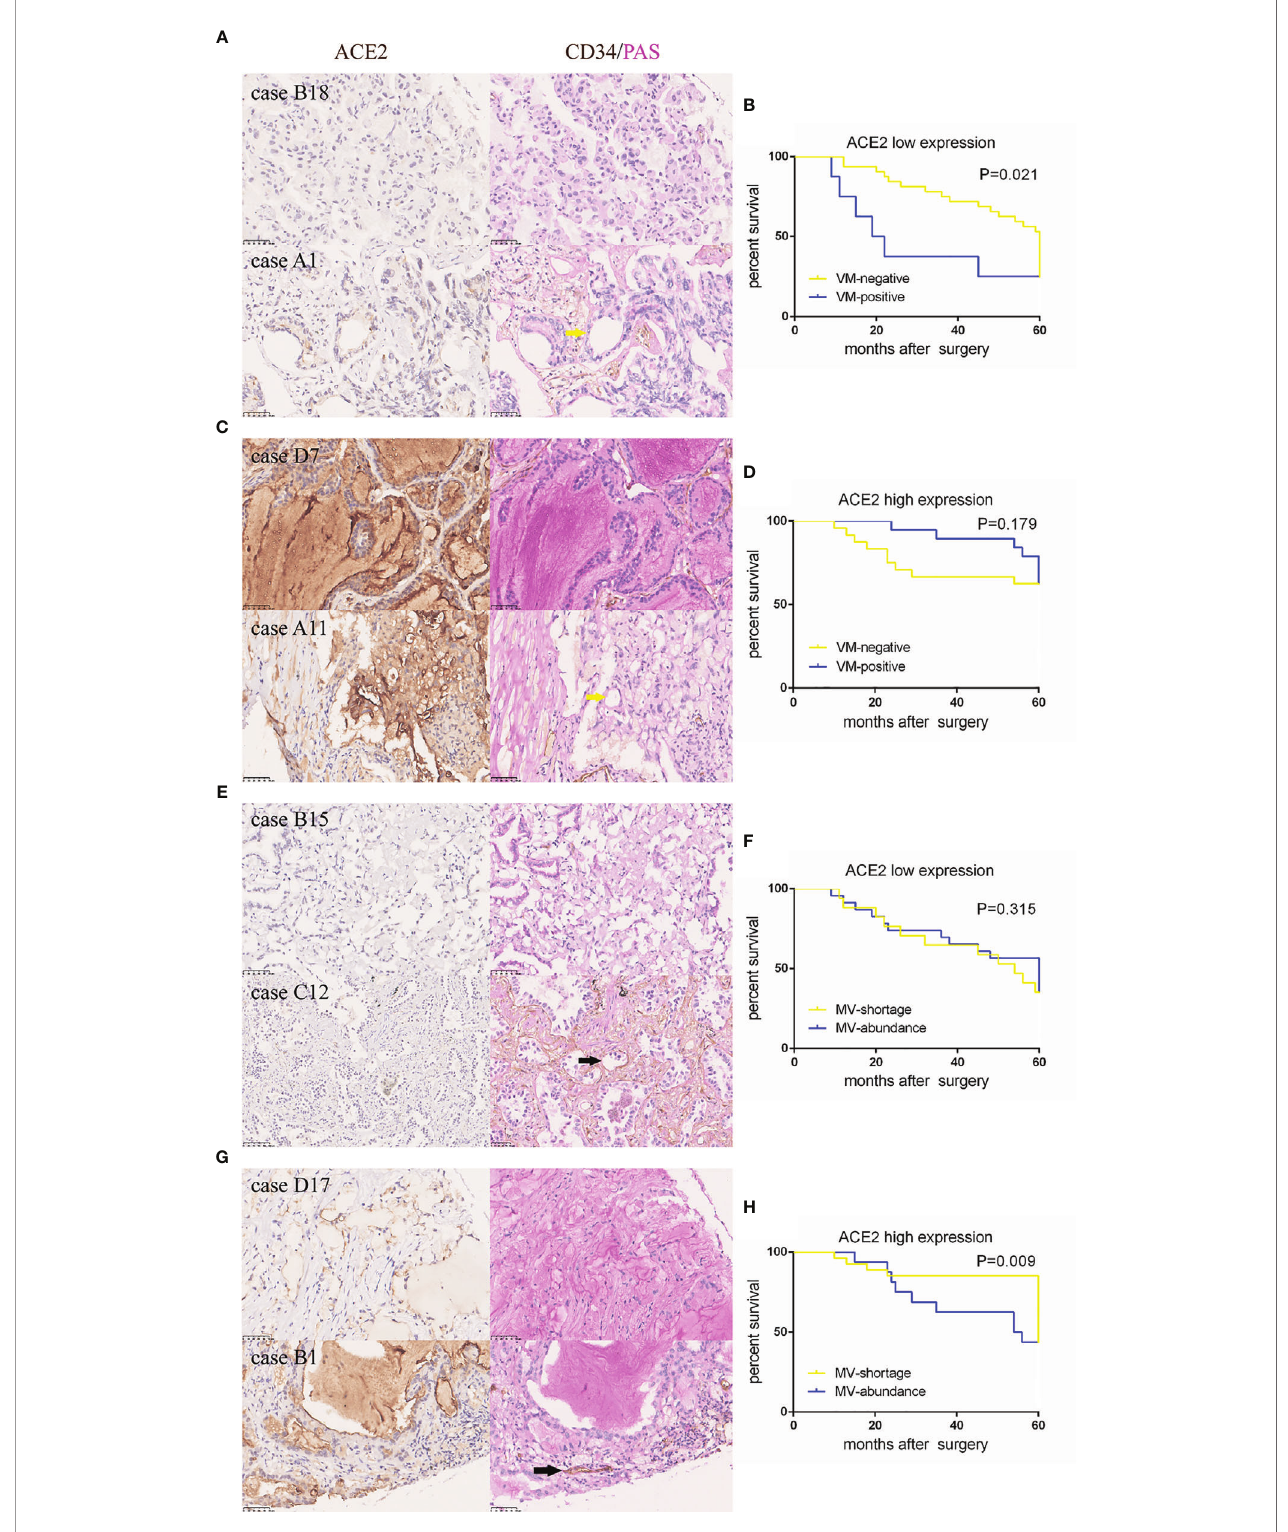
FIGURE 2 | ACE2-induced better outcome in NSCLC patients might be attributed to less vessels and more VM formation. (A, C, E, G) Typical tissue images of each group stained with ACE2 or CD34/PAS. Yellow arrows: CD34 − /PAS + VMs; black arrows: CD34 + /PAS − MV. (B, D, F, H) Kaplan – Meier analysis of OS in each